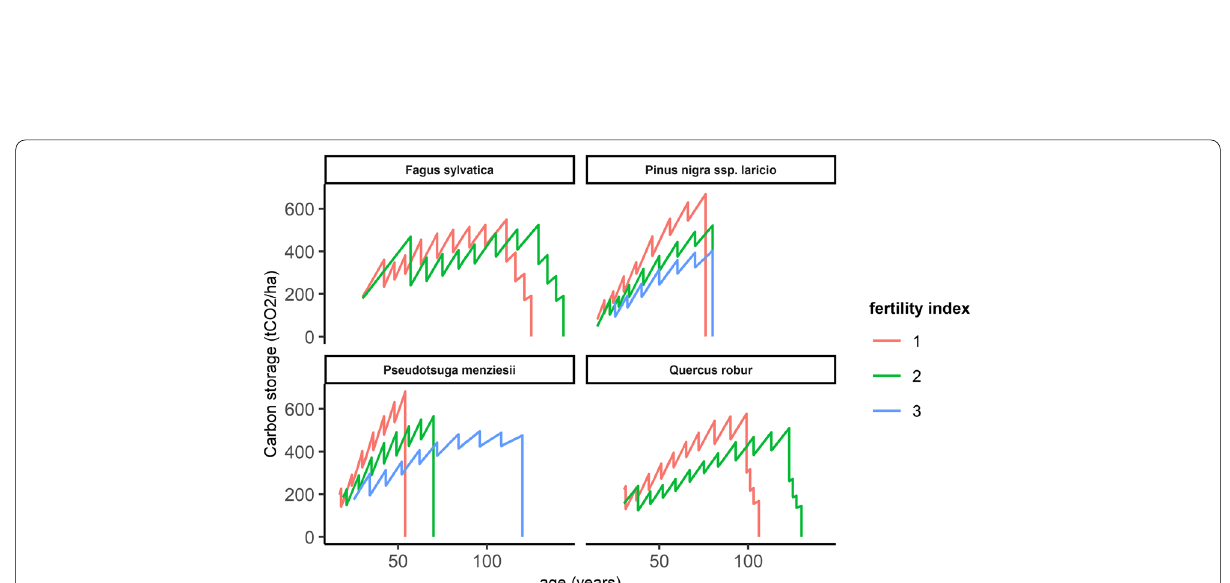
Fig. 3 Temporal evolution of total carbon storage (above and underground carbon) for silvicultural scenarios in stands of contrasted fertility indexes for four common French